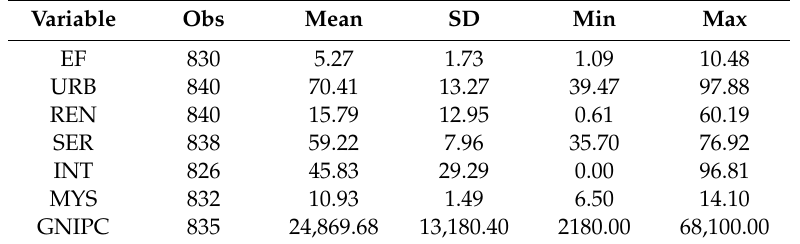
Table 6. Statistical descriptions of the variables for the developed countries (1996–2015).